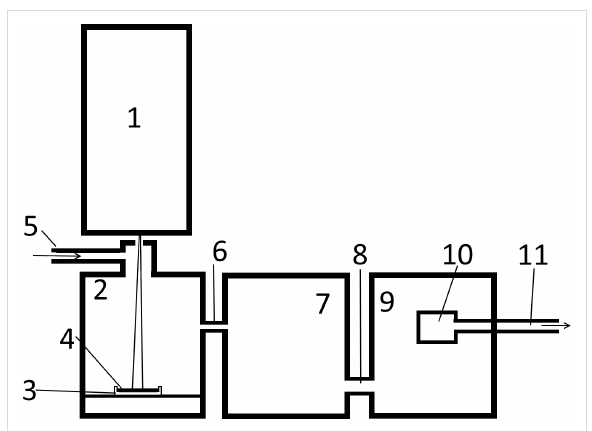
Figure 1: Diagram of the installation for the production of composite nanoparticles. Elements of the installation: 1 – linear electron acceler- ator ELV-6; 2 – evaporation chamber; 3 – graphite crucible; 4 – evapo- rated materials; 5 – input pipe for the transport gas; 6 – connecting pipe; 7 – intermediate chamber for cooling the aerosol and partial deposition of the powder; 8 – connecting pipe; 9 – filter chamber; 10 – filter; 11 – pumping